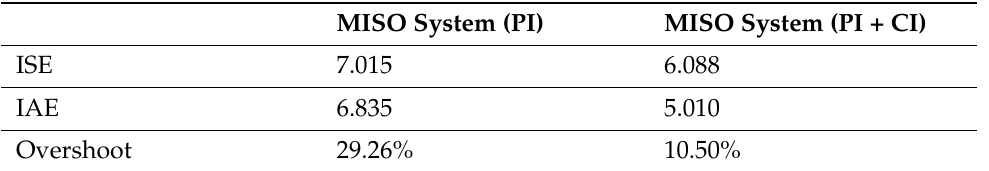
Table 1. Integrated squared error (ISE), integrated absolute error (IAE), and maximum overshoot percentage, for the parallel MISO reset control system and its base